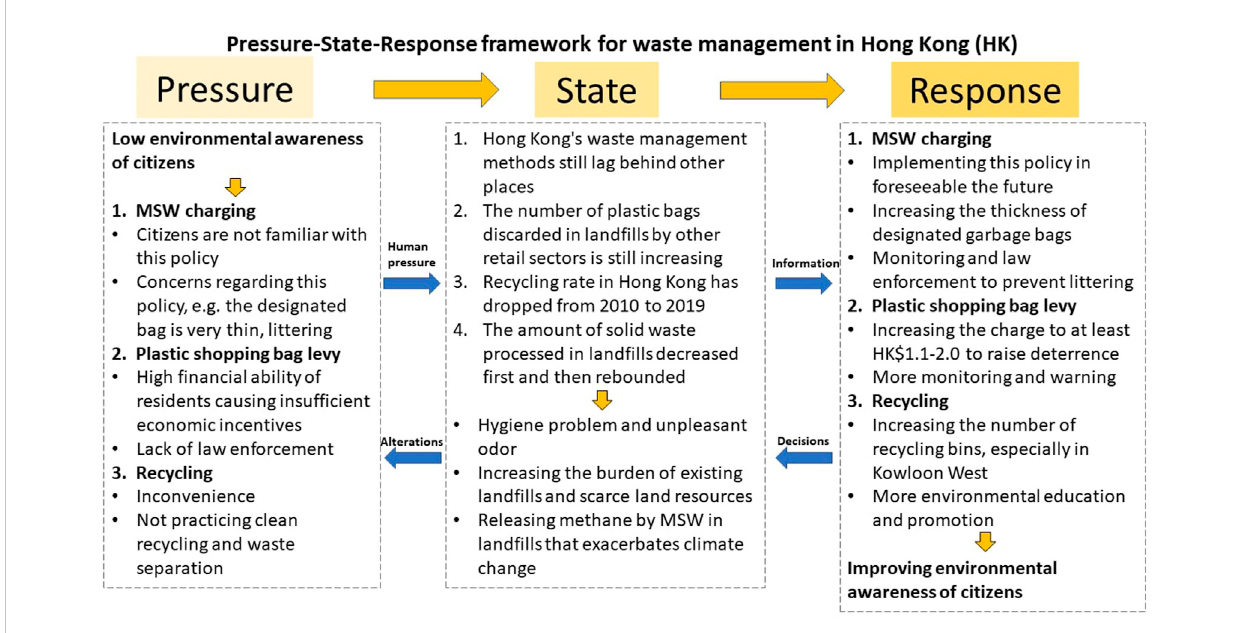
FIGURE 9 Pressure-State-Response framework for waste management in Hong